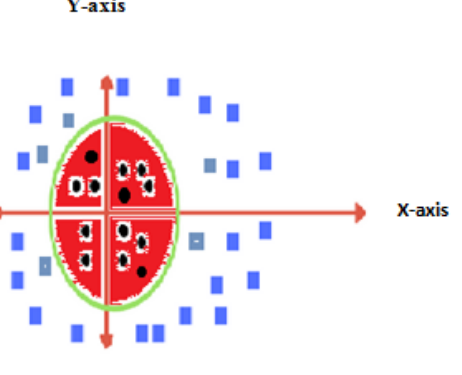
Figure 7. Separation in Complex Data